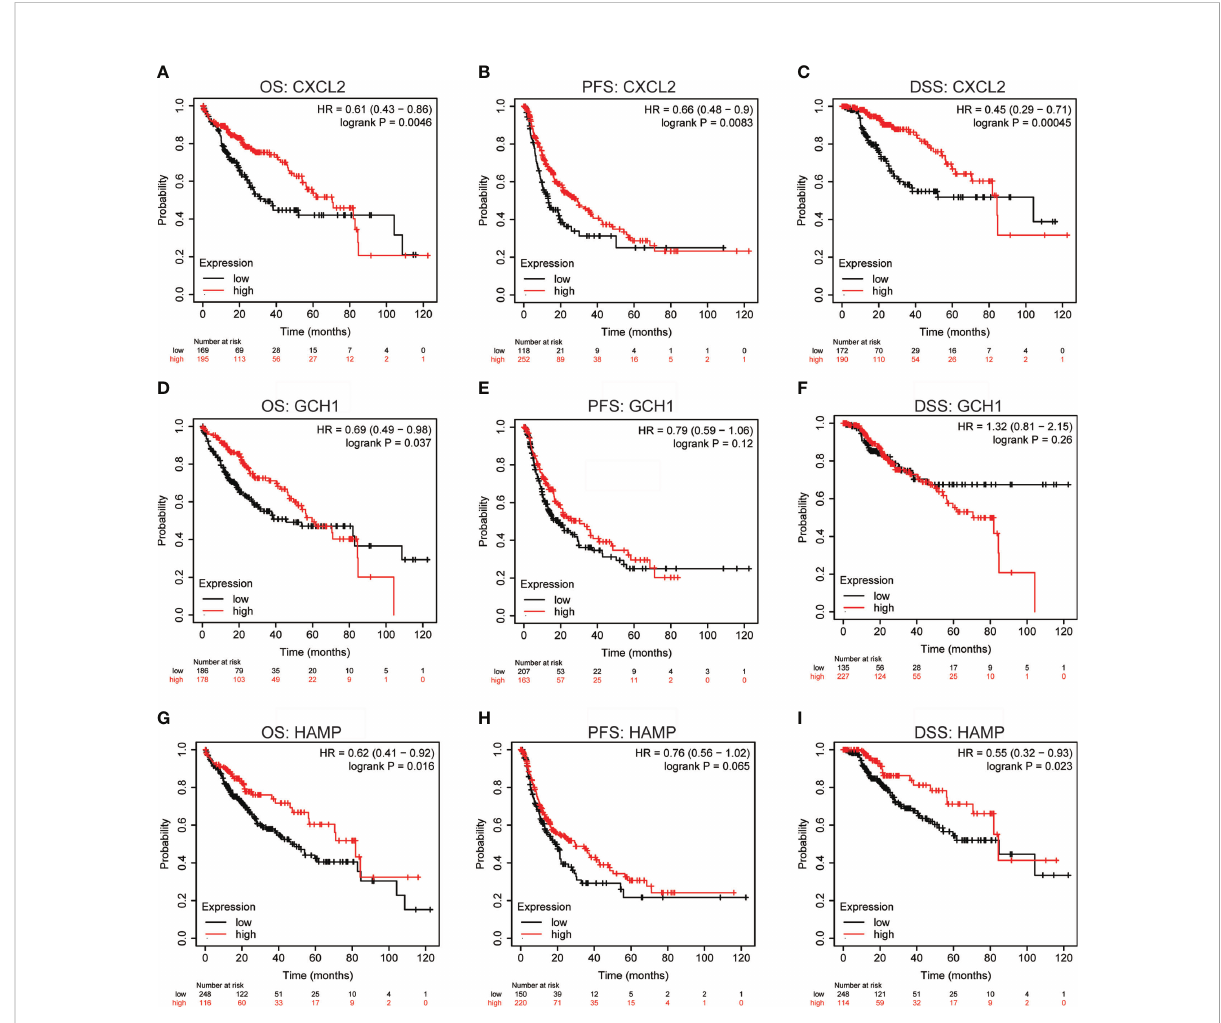
FIGURE 2 Prognostic values of CXCL2, GCH1, and HAMP in HCC. (A-I) Overall survival (OS), progression-free survival (PFS), and disease-speci fi c survival (DSS) Kaplan-Meier curves of CXCL2, GCH1, and HAMP in patients with HCC by Kaplan – Meier plotter